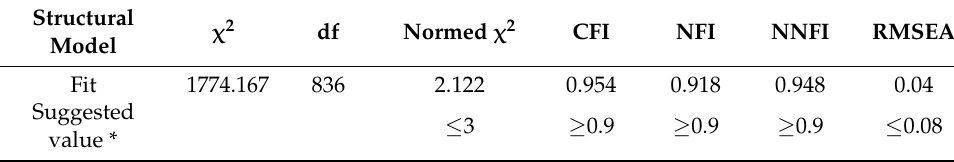
Table 2. Results of Goodness-of-fit indices for measurement model of EMGB.